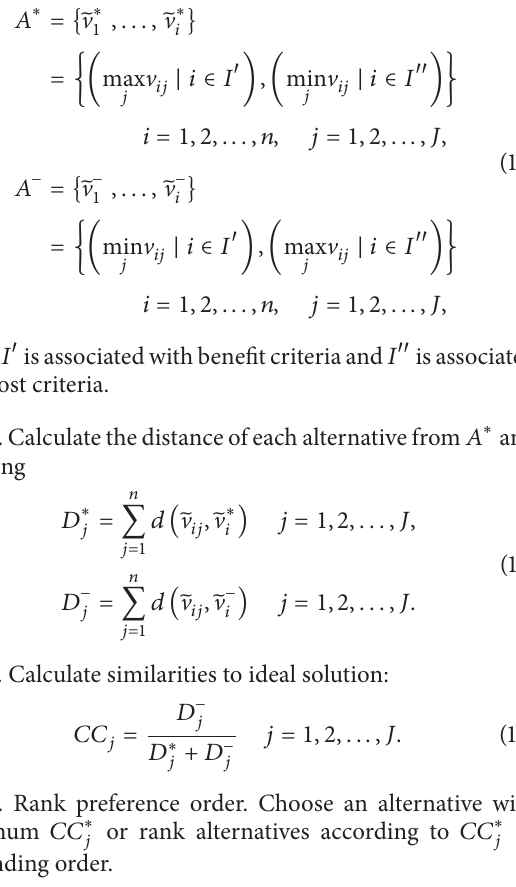
Figure 3: House of